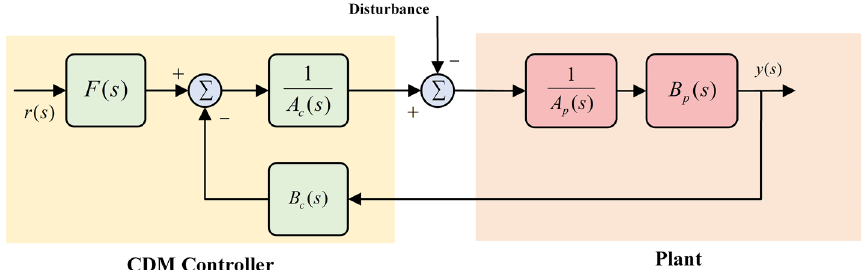
Fig. 2 Schematic diagram of a CDM